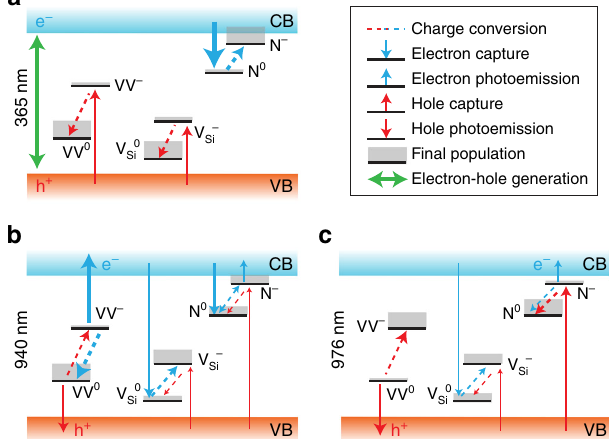
Fig. 6 Summary of charge transfer in semi-insulating 4H-SiC under various illumination conditions. Strong transitions are shown by thicker arrows, and the steady-state population after illumination is approximatively represented by the gray area over each state. a Above-bandgap excitation and electron-hole generation. b Excitation above the VV −